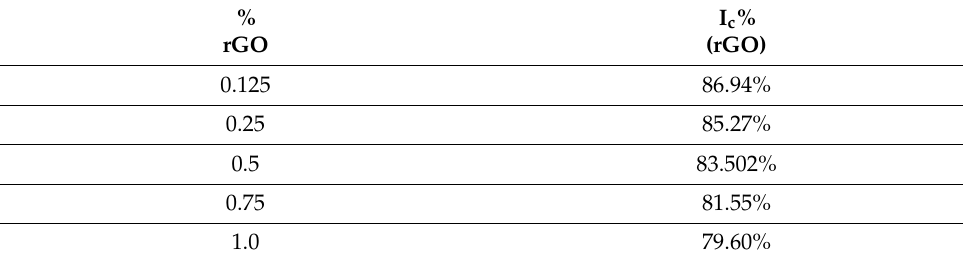
Table 3. Effect of temperature on I c % values of rGO, CuO, and 1.0 Wt.% rGO/CuO at 1 h.